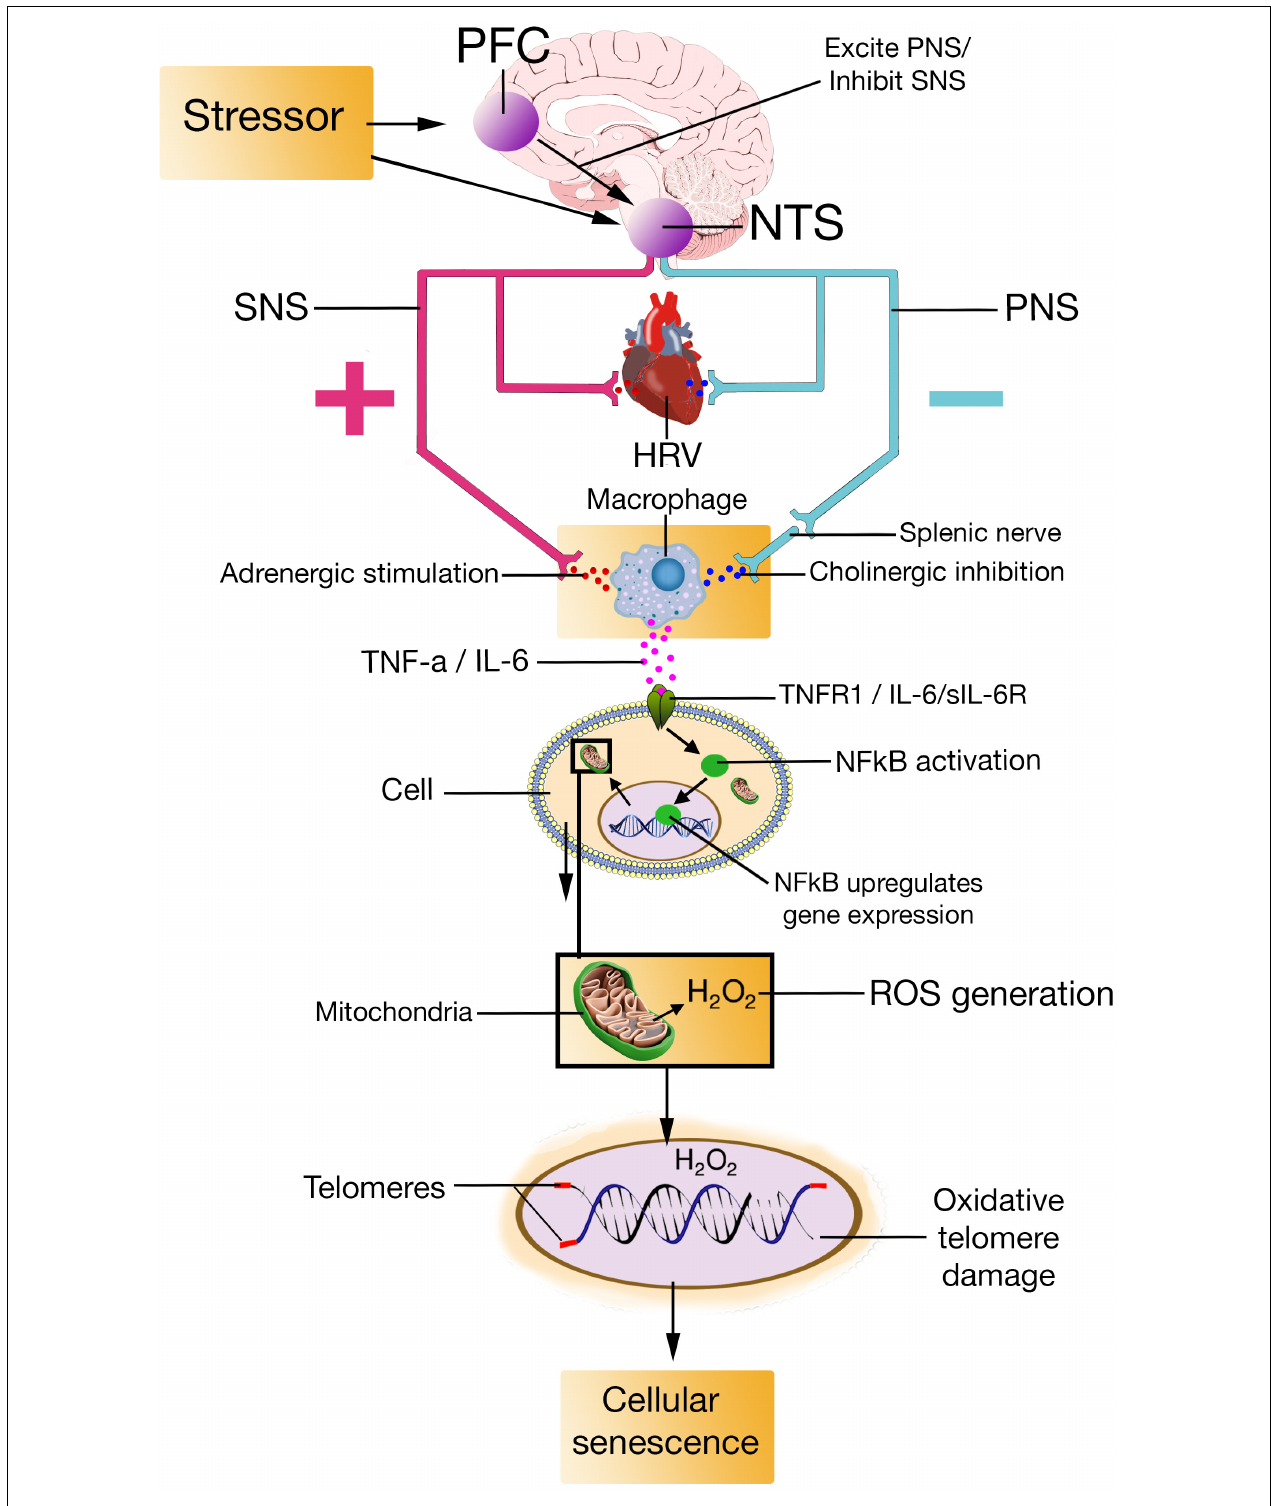
FIGURE 4 | PFC, prefrontal cortex; NTS, nucleus of the tractus solitarius; SNS, sympathetic nervous system; PNS, parasympathetic nervous system; HRV, heart rate variability; TNF-a, Tumor Necrosis Factor-alpha; IL-6, interleukin-6; TNFR1, Tumor Necrosis Factor-alpha Receptor 1; sIL-6R, soluble interleukin-6 receptor; NFkB, Nuclear factor kappa light chain enhancer of activated B cells; H2O2, hydrogen peroxide; ROS, reactive oxygen species.